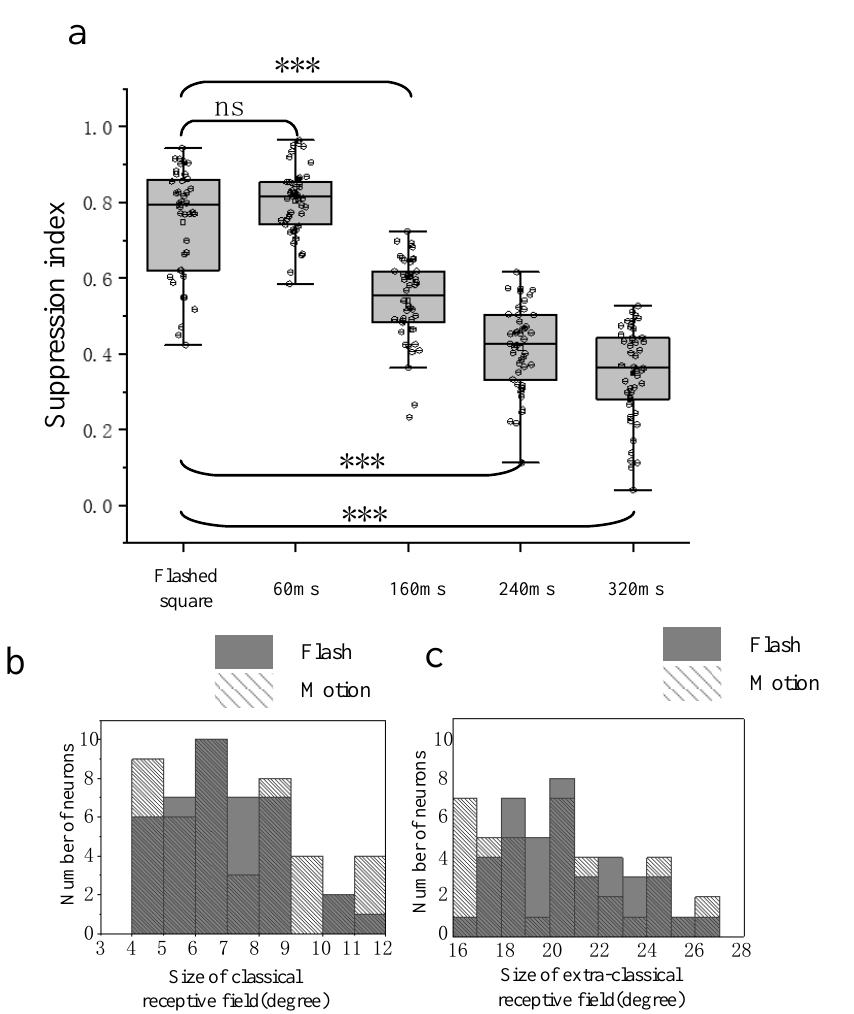
Figure 5. Statistical comparison of surround suppression by flashed and moving stimuli. ( a ) The boxplot graphs of suppression indexes from the moving square stimulus of different widths of the time window and to the flashed square stimulus. The horizontal line indicates the median of each group of data and the whiskers indicate the lowest and highest points within 1.5× the interquartile ranges of the lower or upper quartile, respectively. The ‘ns’ indicates no significant difference between two groups of data (Wilcoxon rank sum test, p > 0.05) and ‘***’ indicates a significant difference between two groups of data (Wilcoxon rank sum test, p < 0.001). ( b ) Distribution of classical receptive field size for all recorded sites estimated in flashed and moving conditions, respectively. Gray filled rectangle indicates results in flashed conditions, while texture filled rectangle indicates those in moving conditions. ( c ) Distribution of extra classical receptive field size for all recorded sites estimated in flashed and moving conditions, respectively. Gray filled rectangle indicates results in flashed conditions, while texture filled rectangle indicates those in moving conditions.